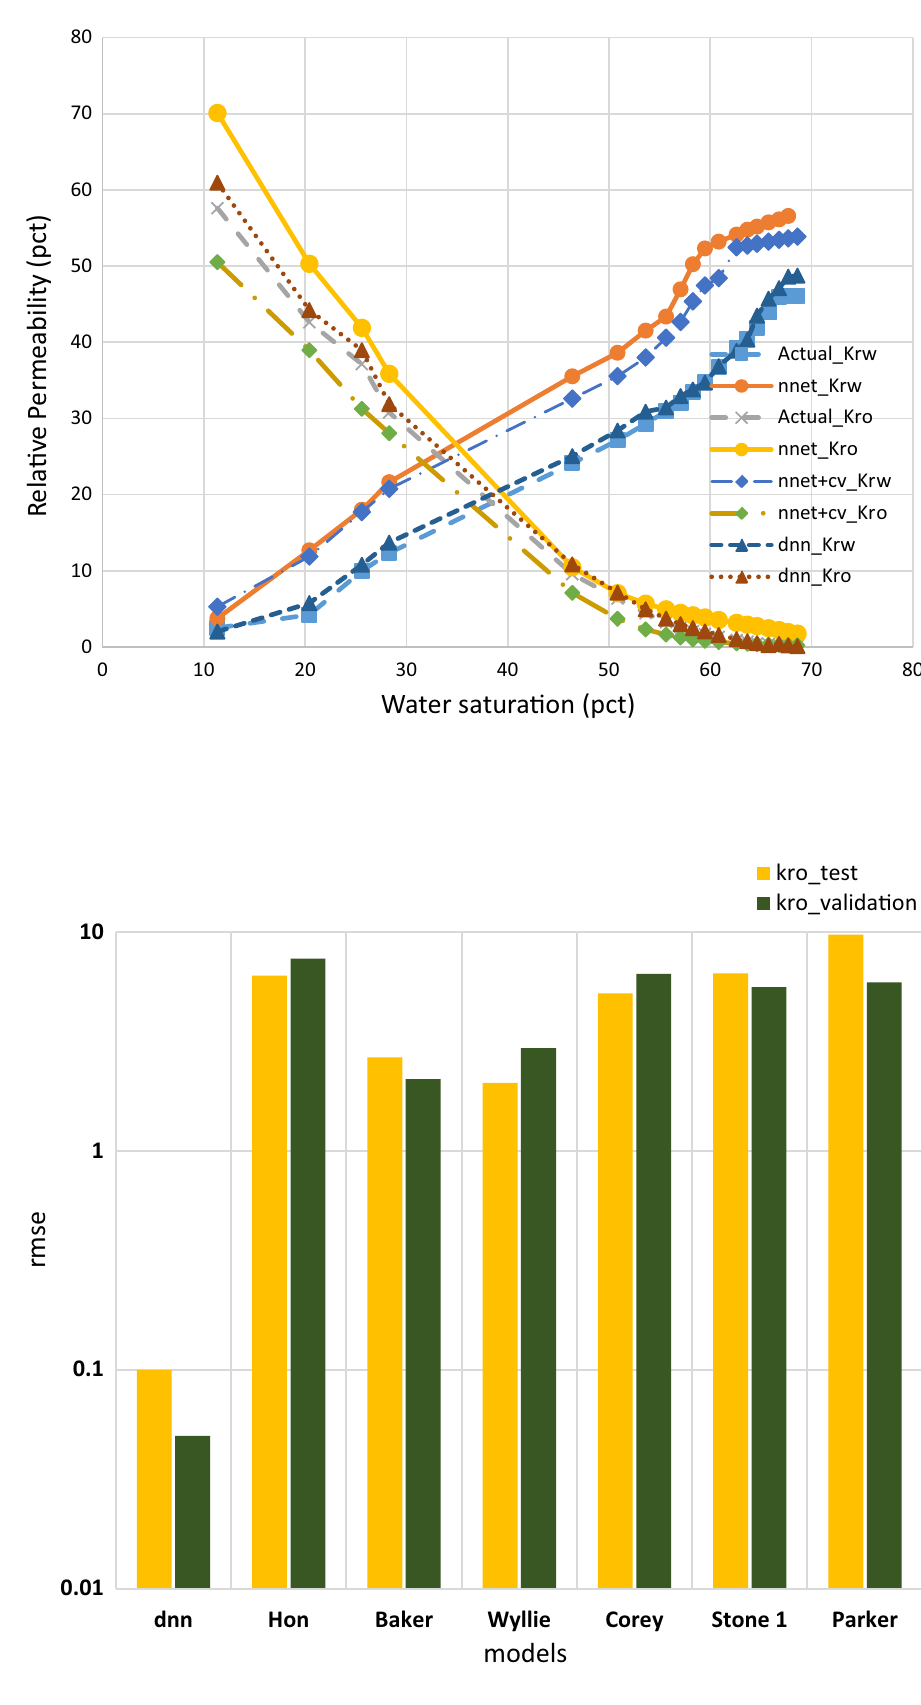
Fig. 8 Experimental (actual) and predicted relative perme- ability models using neural network (both with and without cross validation) and deep neural networks on the out-of-sample test set (Stafjord reservoir). Cross validation (cv) involved in the network helped to improve its accuracy for out- of-sample datasets